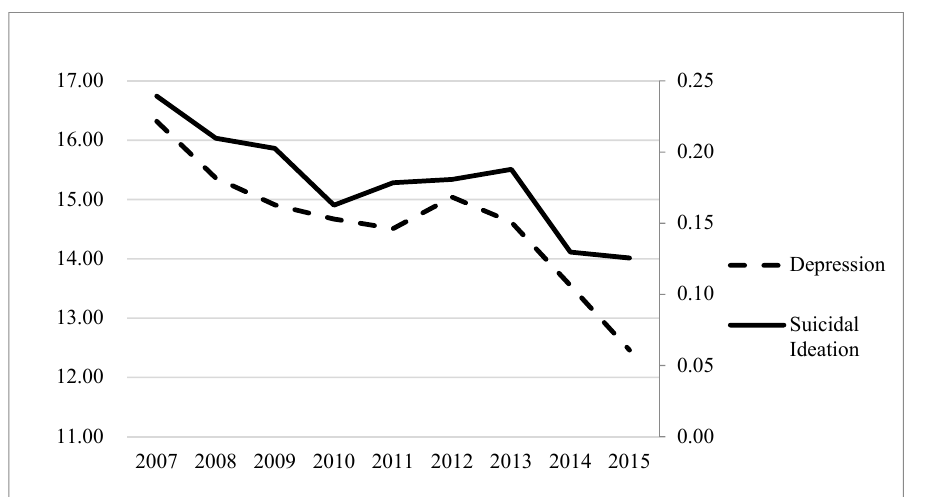
Figure 1. The trend of suicidal ideation and depression from 2007 to 2015. Table 3. Suicidal ideation and depression in college students from 2007 to 2015.